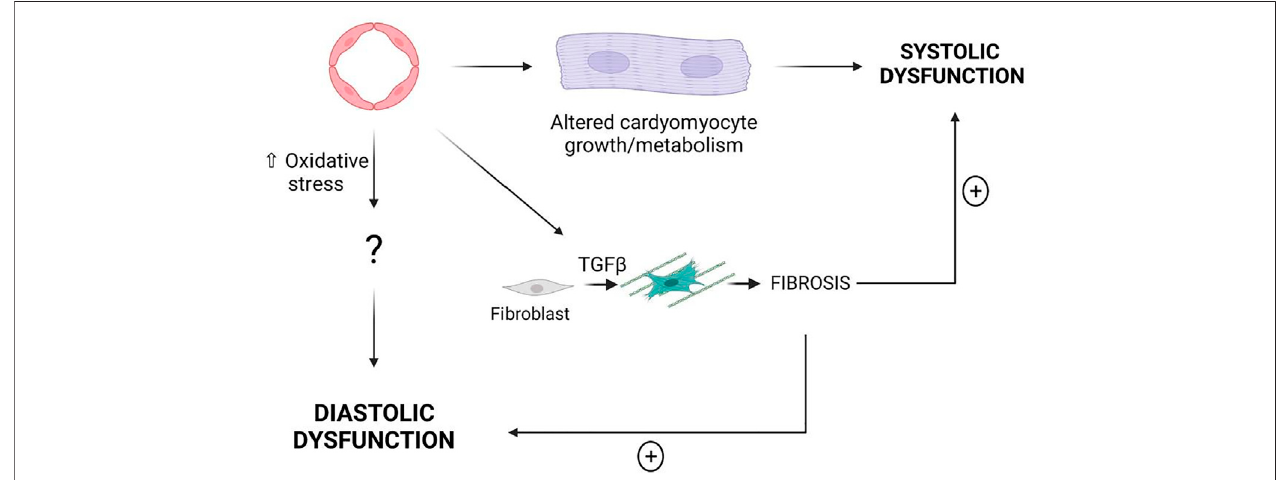
FIGURE4| ECdysfunctionmayinduceeithersystolicdysfunctionordiastolicdysfunction.CardiacFibrosisisnotsuf fi cienttoinduceHFhoweveritmayexacerbate both systolic dysfunction and diastolic dysfunction.